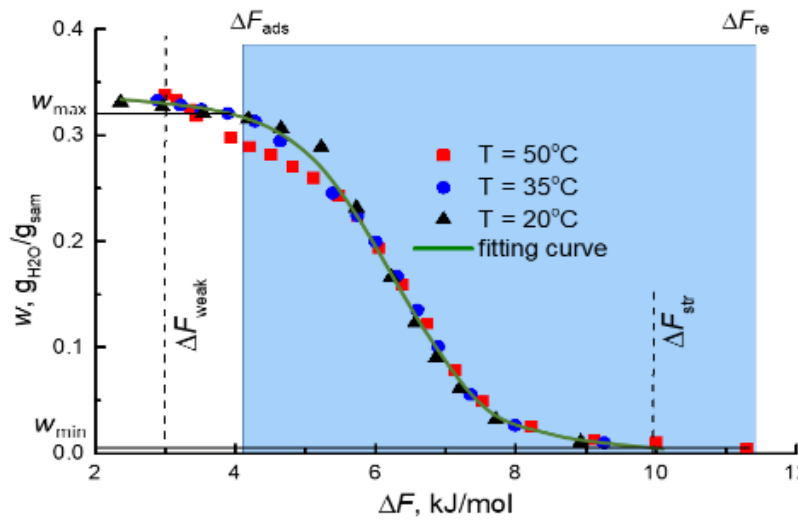
Figure 6. Characteristic curve of water adsorption on the MIL-160 (symbols) and the fitting curve (solid line). Dashed lines indicate the values of adsorption potential, corresponding to the weakest